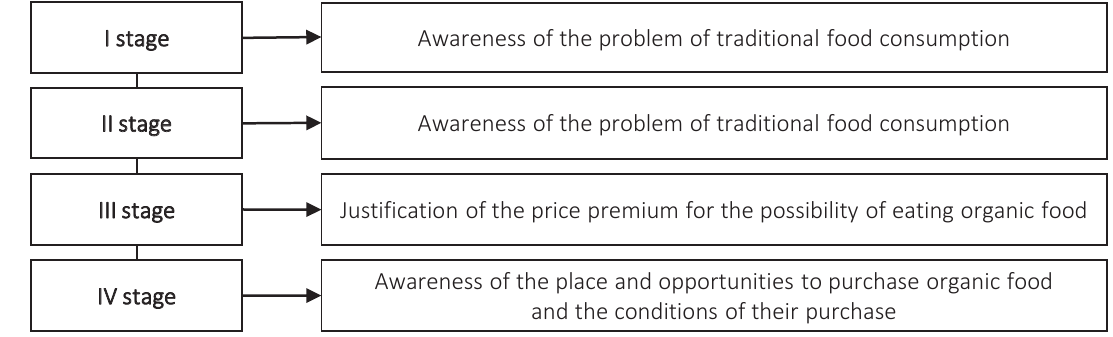
Figure 4. Stages of the process of raising awareness of potential consumers about the possibility of purchasing organic